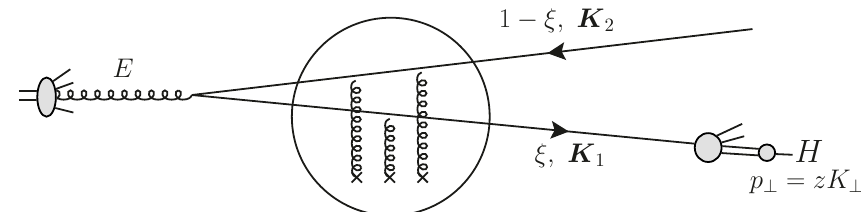
Figure 1 . Contribution to the production of a heavy meson H in pA collisions from the LO process gg → Q ¯ Q (viewed as g → Q ¯ Q forward scattering in the target nucleus rest frame), followed by quark fragmentation Q → H (represented here), or ¯ Q → H . (In addition to the incoming target gluon, the nucleus provides rescattering gluons that contribute to the nuclear p K , respectively. We will assume the transverse momentum imbalance K 2